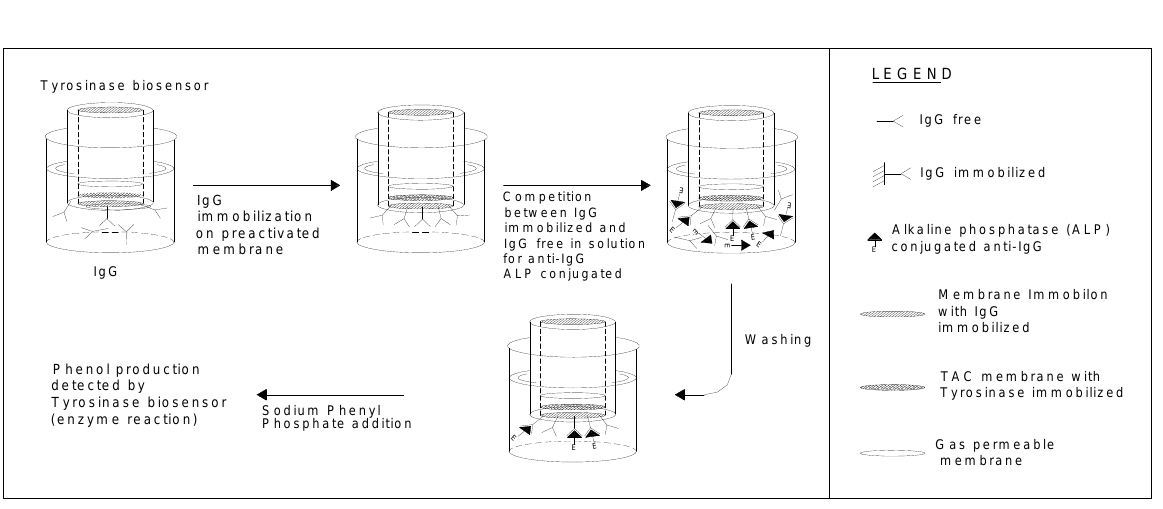
Figure 6. Determination of antigen (IgG) by new immunosensor using tyrosinase enzyme electrode as a transducer. Test geometry: competition for anti-IgG alkaline phosphatase conjugated between IgG immobilized on membrane and IgG free in solution.